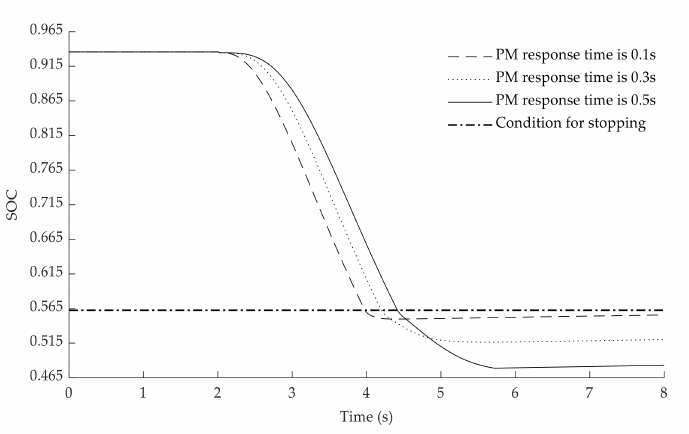
Figure 22. Variation of SOC with different VDPM response